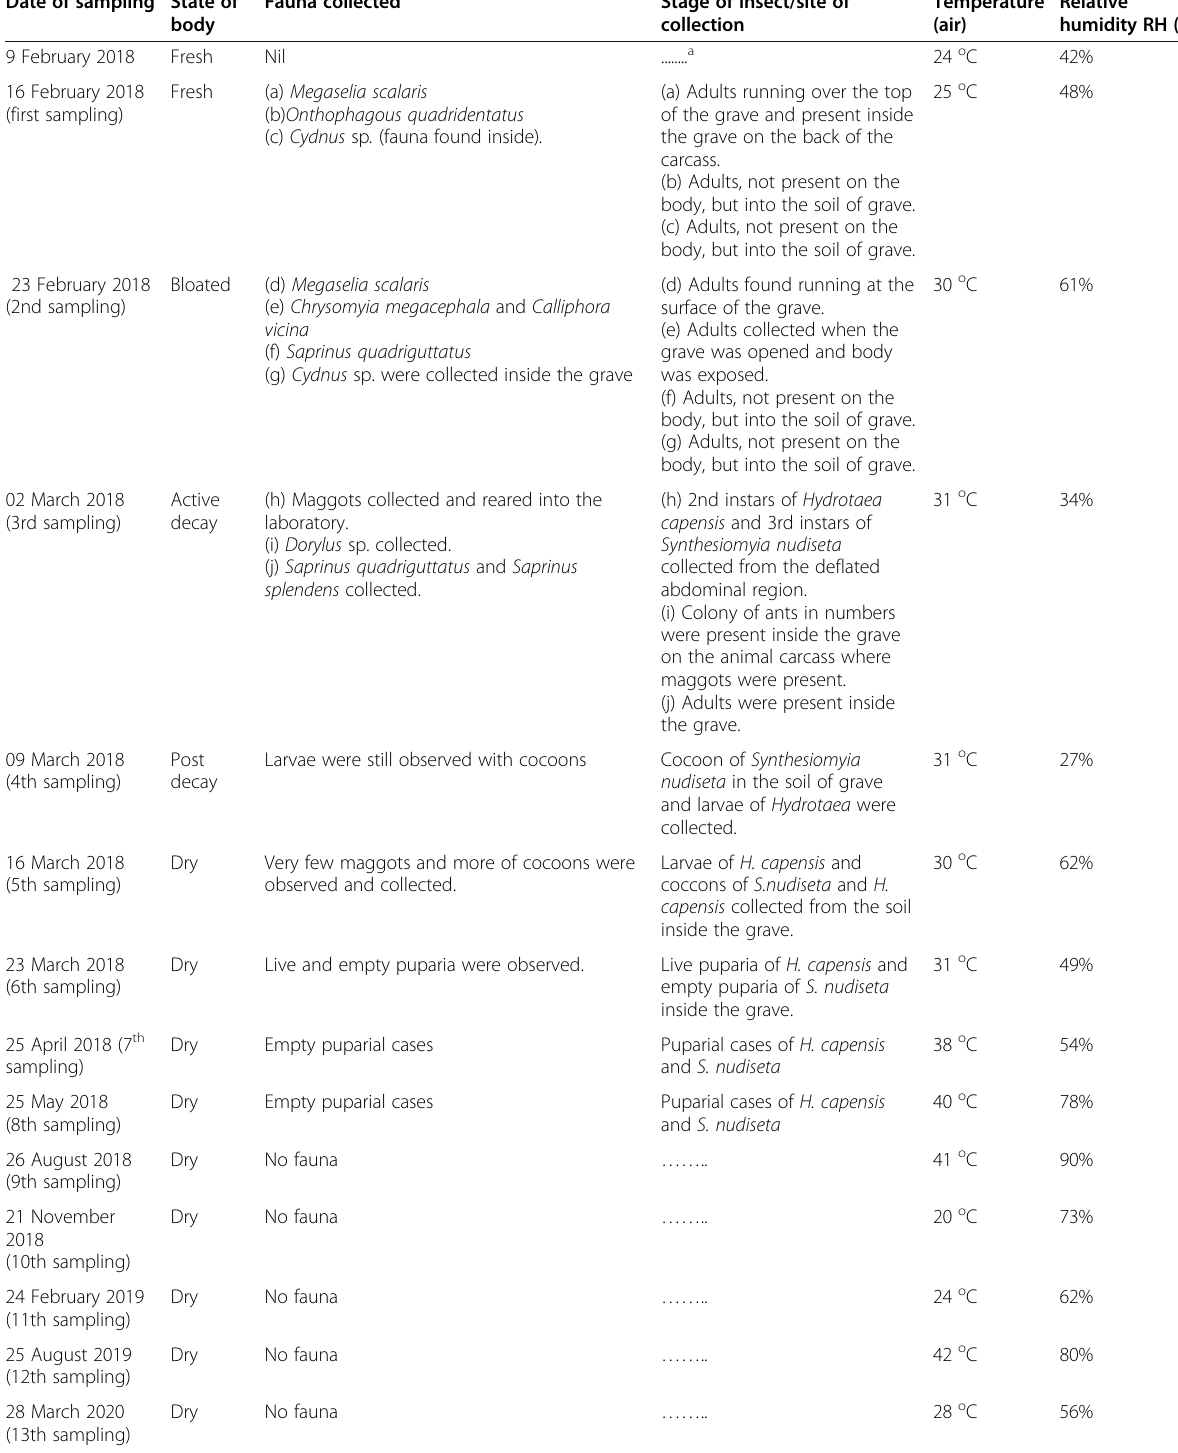
Table 1 Summary of results with date of sampling, fauna collected, site of collection of insects, temperature, and RH of air Date of sampling State of